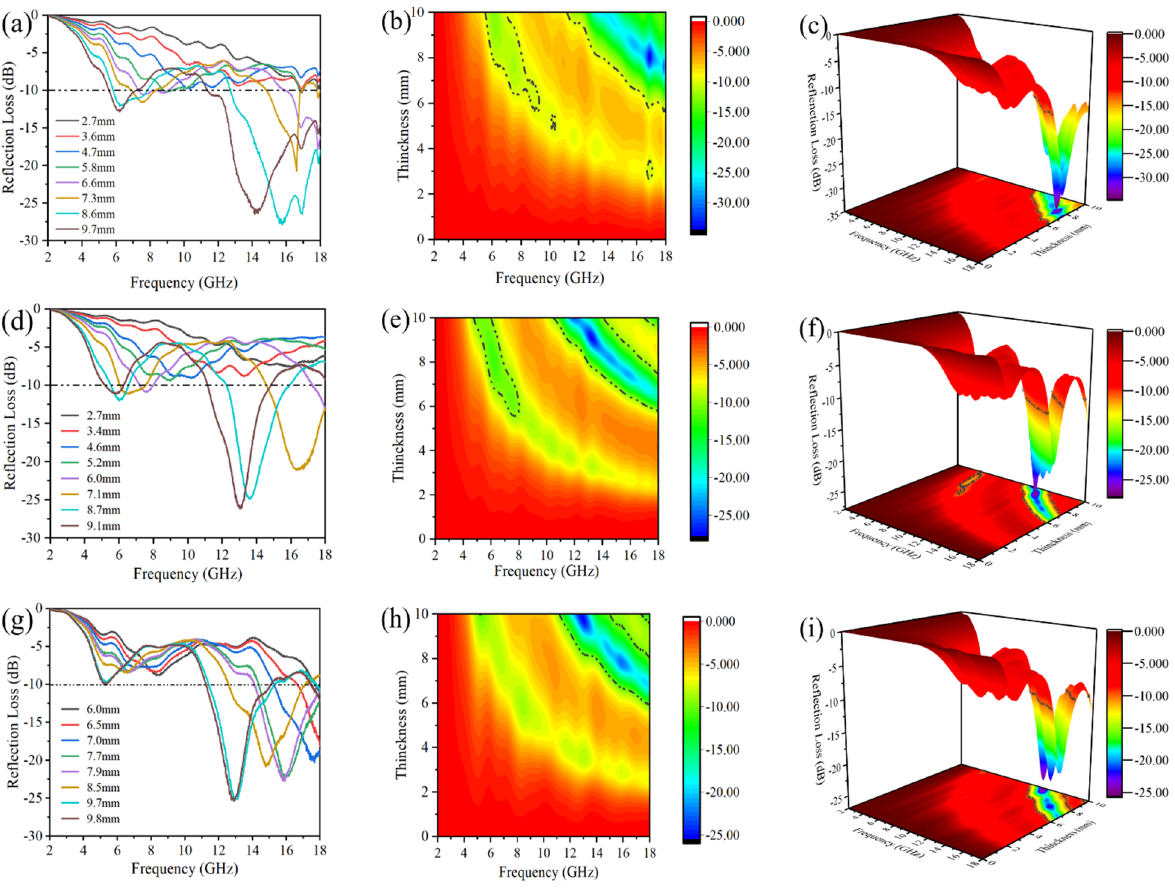
Figure 7. The RL curves, and 2D, 3D color-maps at di ff erent matching thickness of ( a – c ) HEO − Zn, ( d – f ) HEO − Cu, and ( g – i ) HEO − Mn. Table 2. The wave absorbing properties including RL min , matching thickness, and EAB values of the present three ferrite samples, as well as many reported EM absorbing materials.